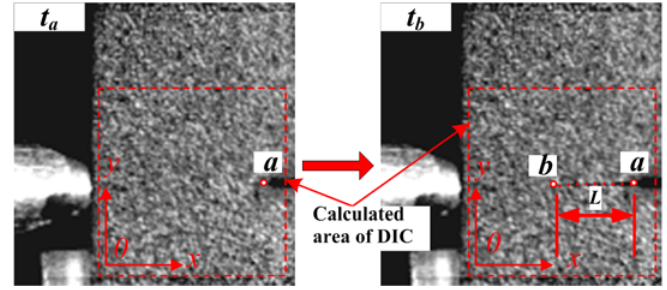
Figure 5. Crack velocity calculated via the DIC method.